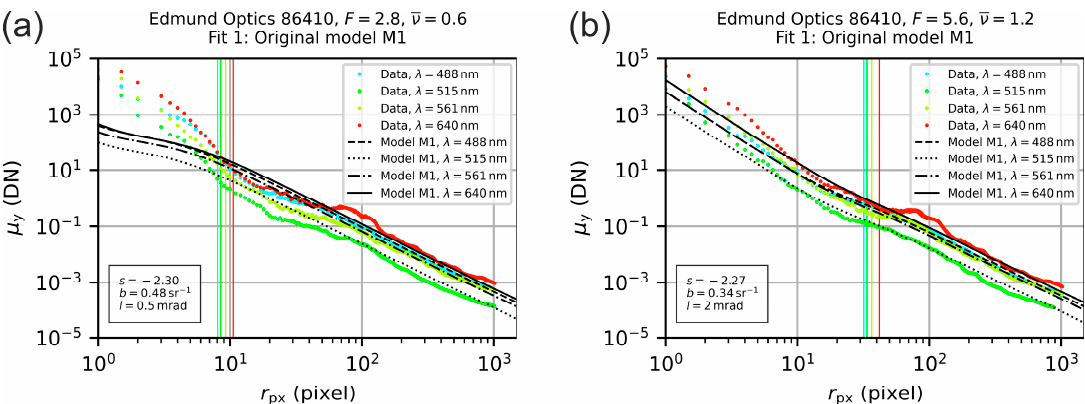
Figure 13. Radial irradiance distribution for the lens Edmund Optics 86410 operated with an f-number of ( a ) 𝐹 = 2.8 and ( b ) 𝐹 = 5.6 . The colored points represent the measured values. The lines are the result of fitting the theoretical model M1 to the data. The vertical lines indicate the values of the respective scatter parameters 𝑙 .